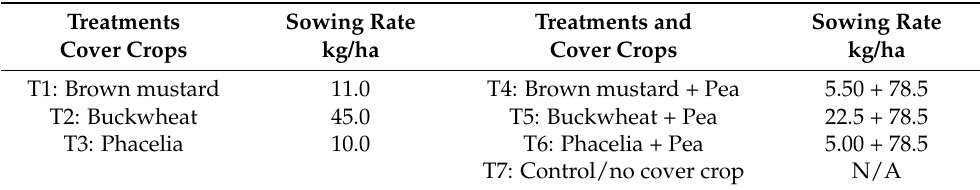
Table 2. Experimental treatments, names of cover crops, and seed sowing rates (kg/ha) for each of the seven treatments for Experiment 1.